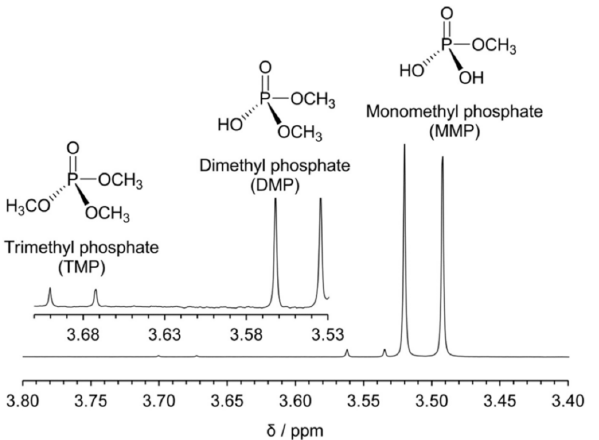
Figure 6. Identification of methyl phosphate at a degraded MEA and the chemical structures of the corresponding phosphoric acid methyl ester derivatives from Ref. [111]. Table 3 listed the membrane properties of some representative studies on promoting the proton conductivity of PBI PEMs in DMFCs by PA doping. In addition to modifying the preparation methods of PBI PEMs, methods of synthesizing PBI with modified groups, applying nanomaterials, and using crosslinkers are also applied in promoting the acid retaining properties of PBI in high-temperature DMFCs, the relative works are intro- duced in the next section. Table 3. The membrane properties of some representative studies on promoting the proton conductivity of PBI PEMs in DMFCs by PA doping.